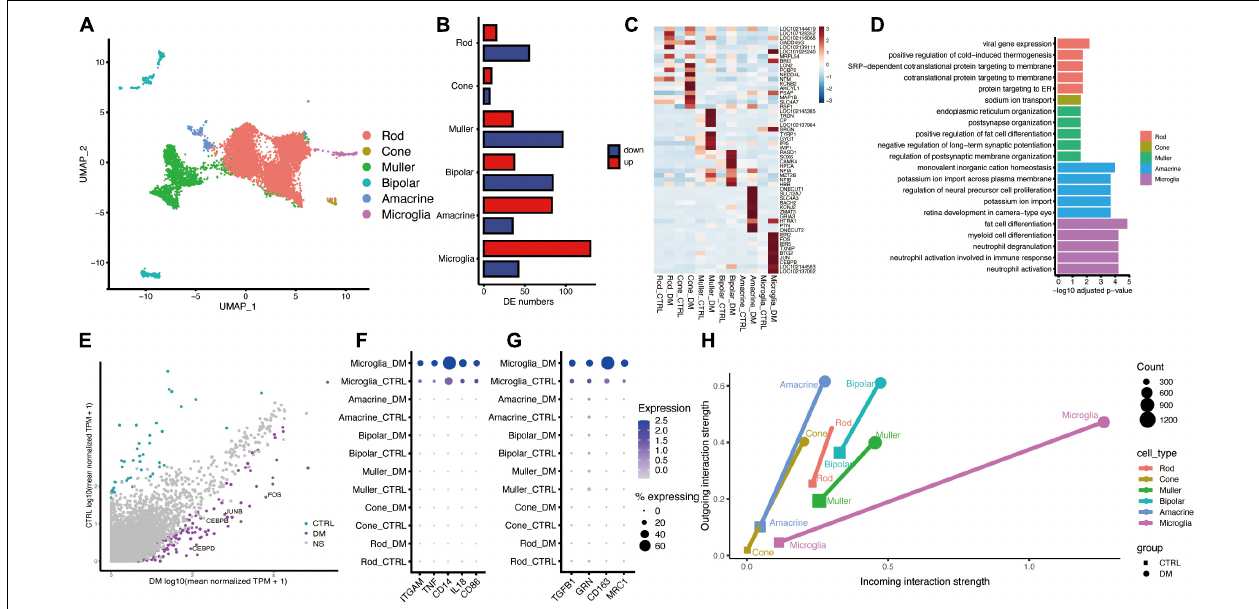
FIGURE 1 | The single-cell atlas and interactome of the monkey retina under diabetes mellitus. (A) UMAP plot showing the identified cell types, including Rod, Cone, Muller, Bipolar, Amacrine, and Microglia. (B) Bar plot showing the number of DEGs between diabetes and control groups. (C) Heatmap showing top ( n = 10) up-regulated hyperglycemia-associated DEGs in different cell types. (D) Representative GO terms of hyperglycemia-induced genes in each cell type. (E) Scatter plot showing DEGs of Microglia. Purple and cyan denote genes that are significantly changed under DM. (F,G) Dot plot showing the augmented expression of pro-inflammatory genes (F) and anti-inflammatory genes (G) in microglia under DM. (H) Dot plot showing the strength of outgoing and incoming interaction of different cell types under normal and hyperglycemia conditions. The length of the line connecting two dots of the same cell type corresponds to extent of the